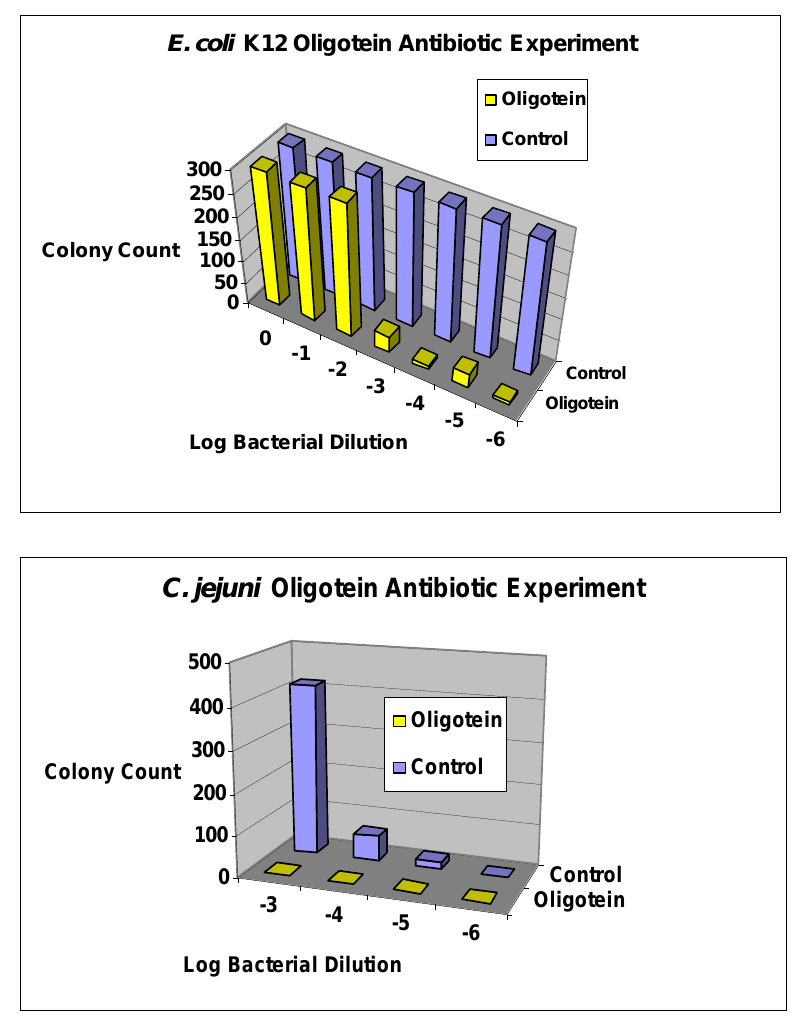
Figure 4. Further examples of aptamer-biotin-streptavidin-C1q killing of Gram negative bacterial species. Top panel shows results for E. coli strain K12 with clear cytopathic effect at 10 −3 dilution and beyond. Bottom panel shows killing of Campylobacter jejuni at the same dilutions. “Oligoteins” indicate where aptamer-biotin-streptavidin-C1q conjugates were